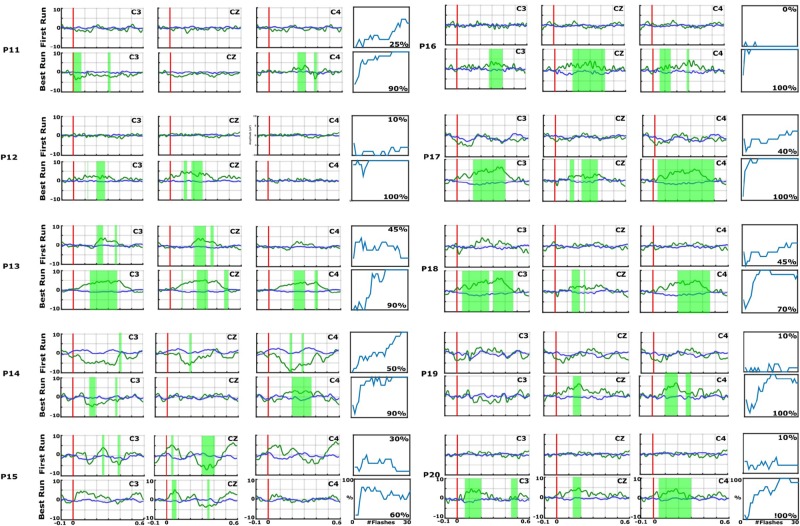
EPs and accuracies for P11–P20, with the same format as the preceding figure. In each EP plot, the red line shows stimulus onset, the blue line shows EPs from non-target trials, and the green line shows the EPs from target trials. Green shaded areas are time regions with statistically significant differences between target vs. non-target trials (p < 0.05). The figure to the right of each EP plot shows the classification accuracy over the number of target events. This figure presents the median accuracy for each session. The first run performed before the 10 sessions is compared with the best run during the therapy to highlight the training process.